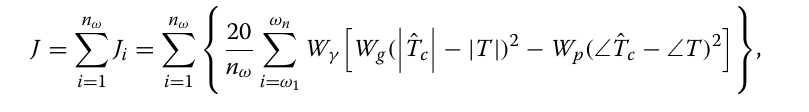
f f where G xy and G xx represent the cross-power spec- (cid:31) (cid:30) (cid:31) (cid:30) tral function and self-power spectral function, respec- tively. The objective of system identification is to make ˆ T the estimation matrix c of the frequency response conform to the actual data matrix. The model adopted through identification is the output error model, and the identification criteria are expressed as